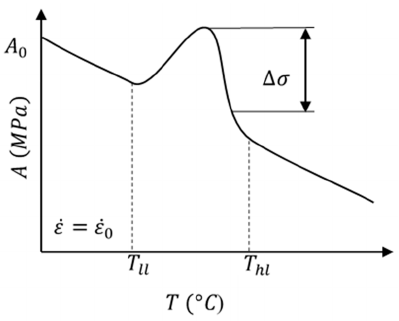
Figure 1. Schematic of the Voyiadjis-Abed-Rusinek (VAR) model-based modification of the JC model’s initial yield stress parameter with corresponding mathematical equations with A0 representing the constant, A, of the JC